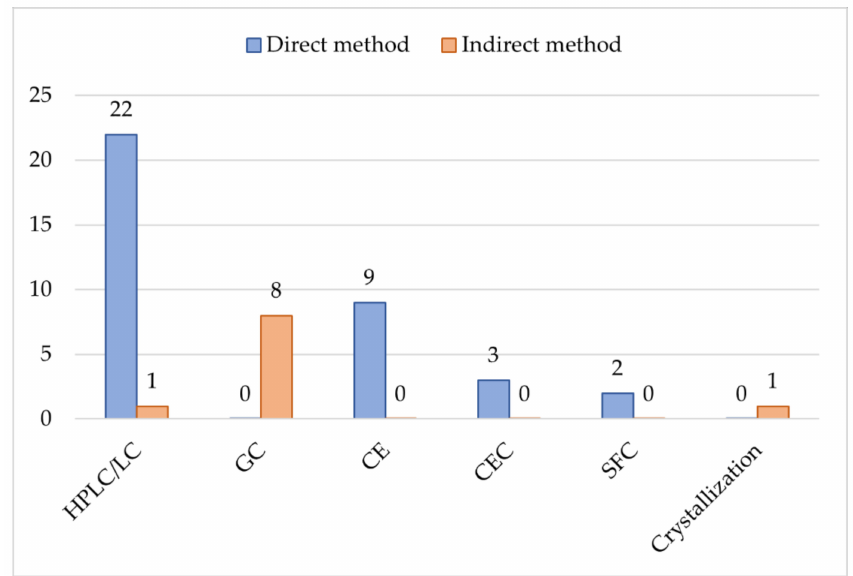
Figure 19. Methods used for the enantiomeric resolution of cathinones. HPLC: high-performance liquid chromatography; LC: liquid chromatography; GC: gas chromatography; CE: capillary elec- trophoresis; CEC: capillary electrochromatography; SFC: super critical fluid chromatography.